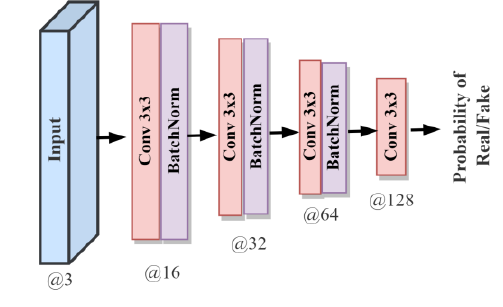
Figure 4. The structure of the